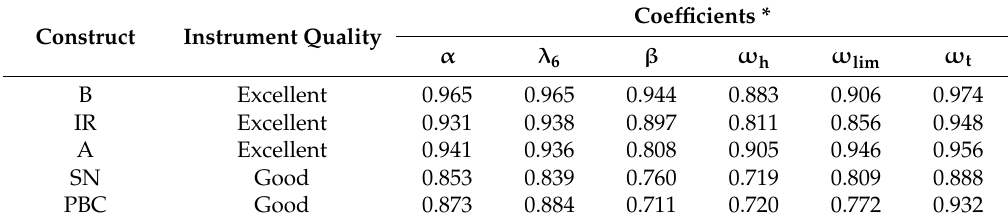
Table 7. Reliability and internal consistency of the TPB constructs.